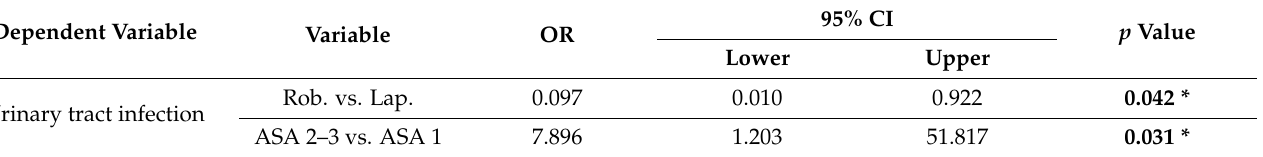
Table 3. Multiple Logistic Regression Analysis of Potential Risk Factors for Urinary Tract Infections.